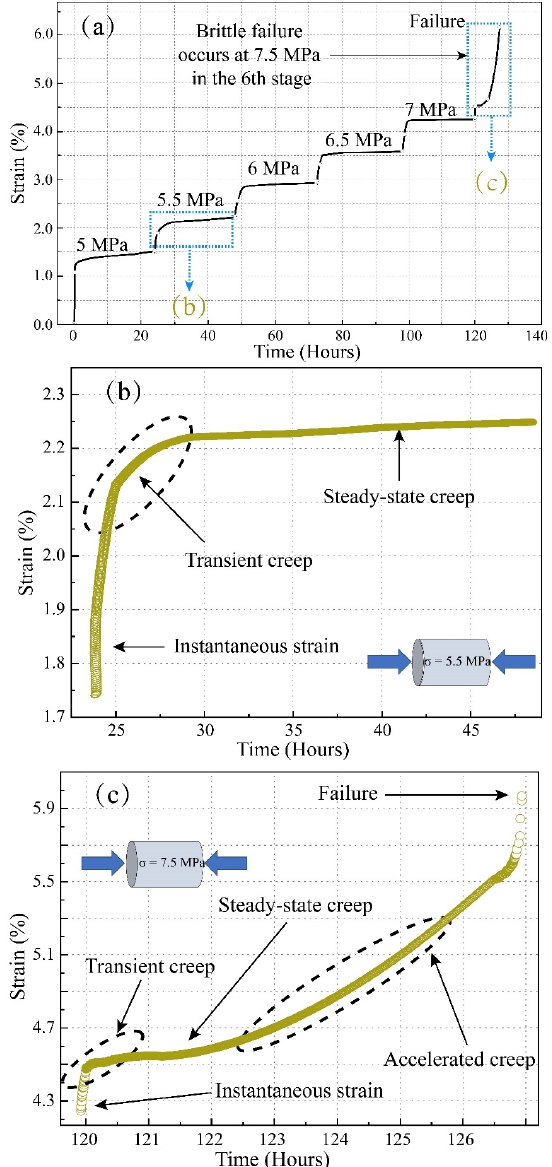
Figure 4. Strain–time curve under multi-stage constant load: ( a ) Creep process curve under multi- stage constant load; ( b ) Stable creep curve under constant load of 5.5 MPa; ( c ) Accelerated creep curve under constant load of 7.5 MPa.